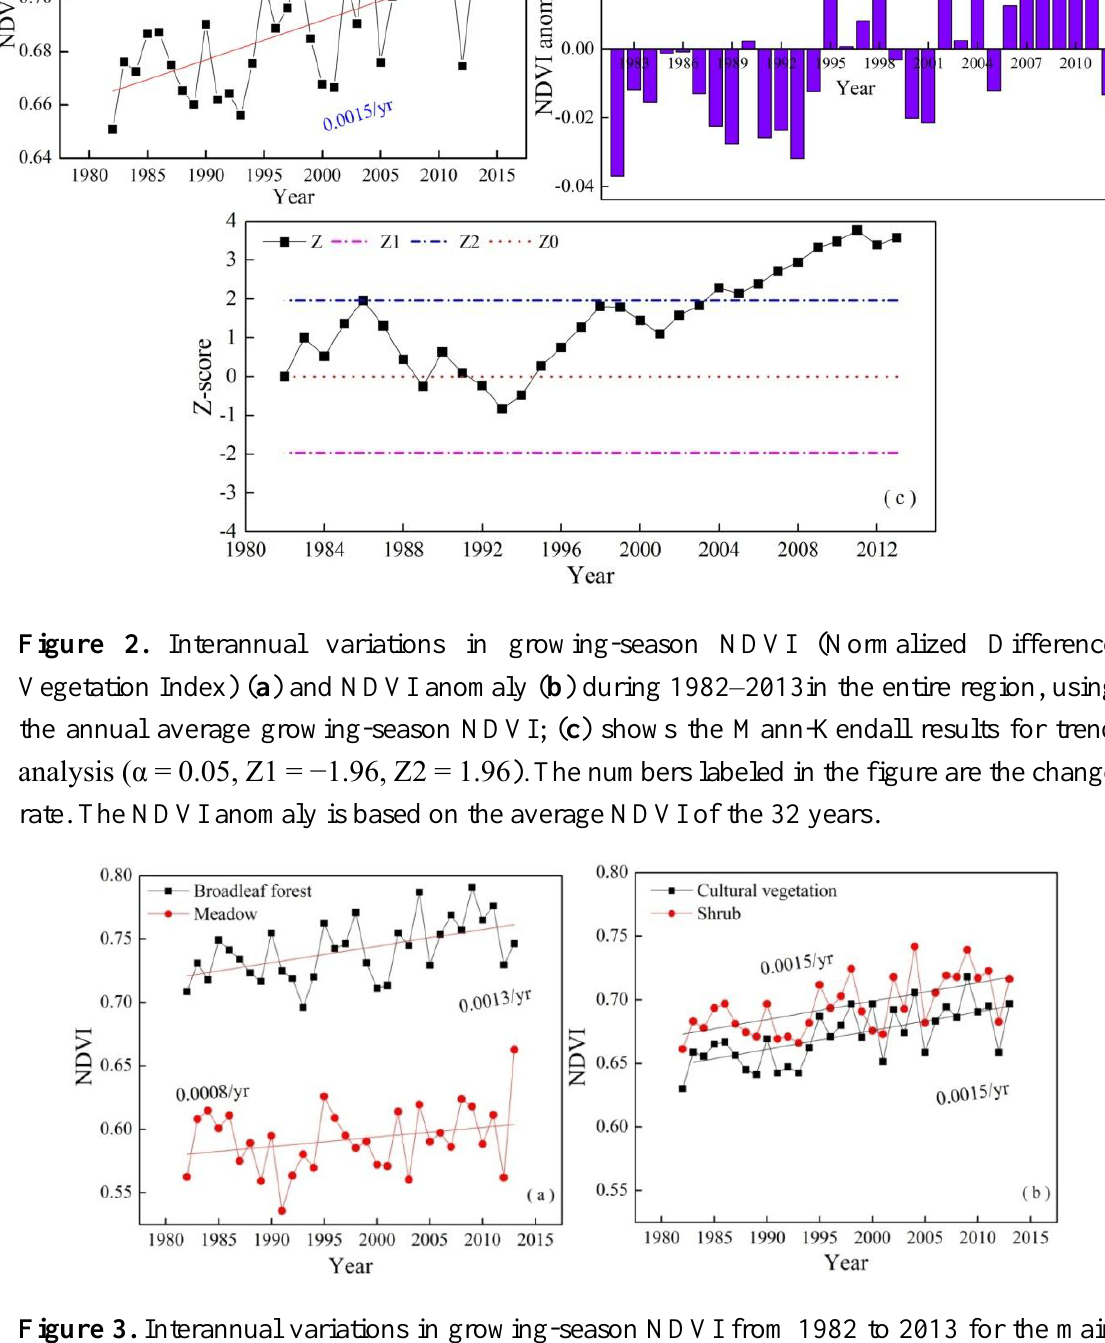
Figure 3. Interannual variations in growing-season NDVI from 1982 to 2013 for the main vegetation types ( a , b ), using the annual average growing-season NDVI. The numbers labeled in the figure are the change rate of different vegetation